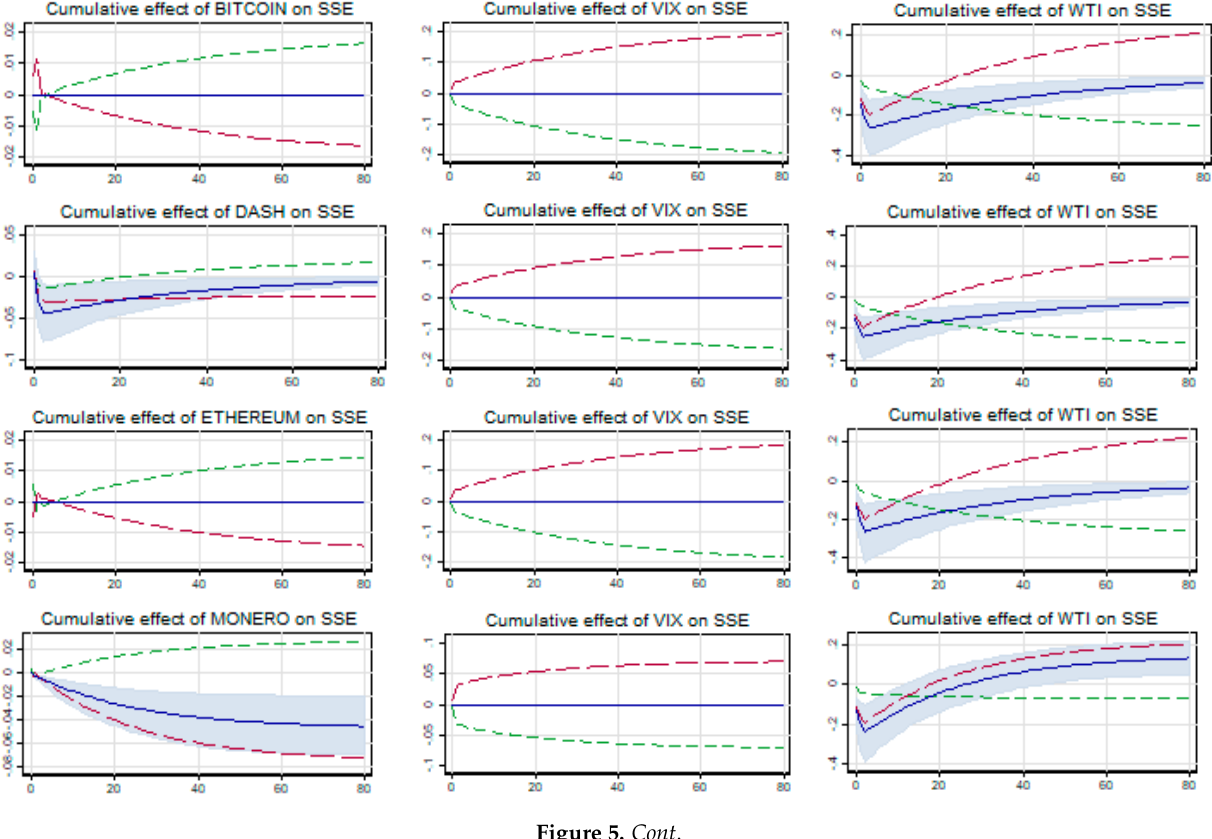
Figure 5. Cumulative effects of cryptos and gold on RTSI.